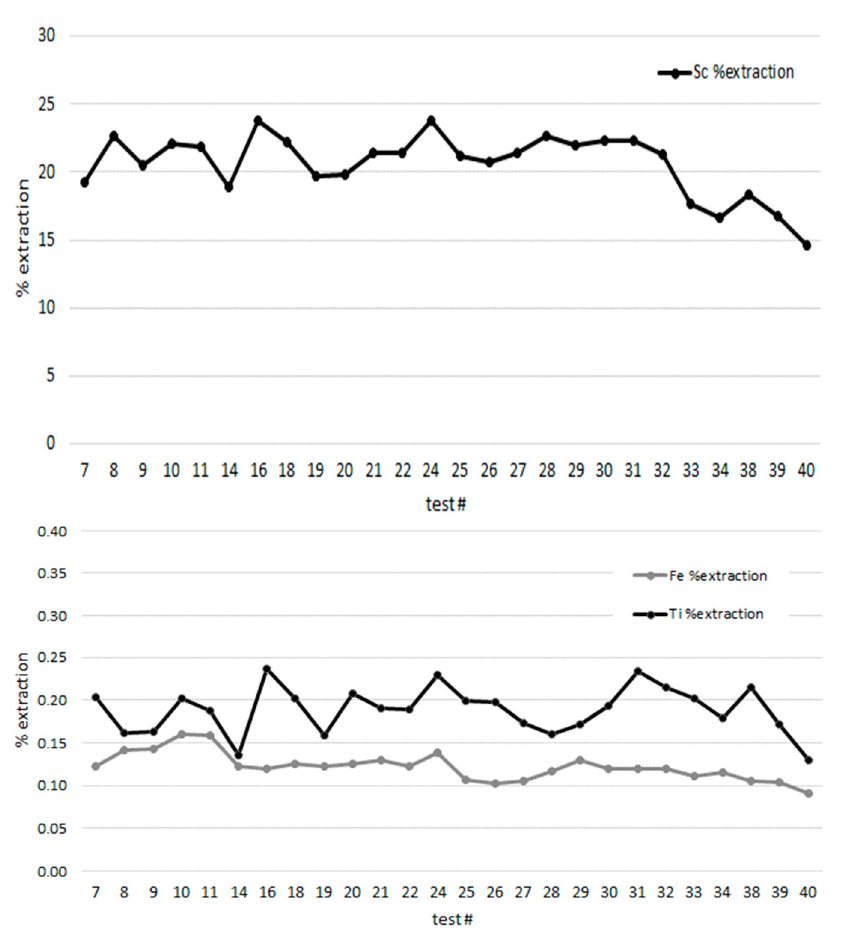
Figure 2. Leaching extraction (%) of Sc (top), Fe, Ti (bottom) achieved in pilot tests.